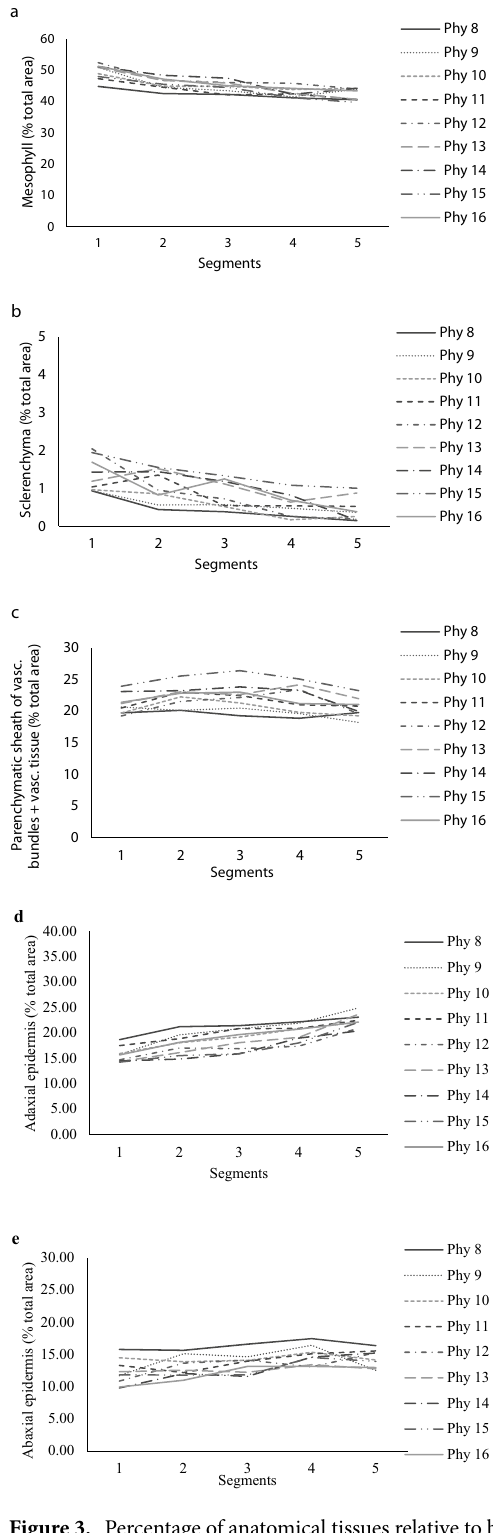
Figure 3. Percentage of anatomical tissues relative to blade total cross-section area of leaves with contrasting levels of insertion on the tiller axis (phytomers) of Napier elephant grass. ( a – e ): mesophyll, sclerenchyma, parenchymatic sheath of vascular bundles + vascular tissue, adaxial and abaxial epidermis, respectively. Phytomers were individually harvested soon after leaf complete